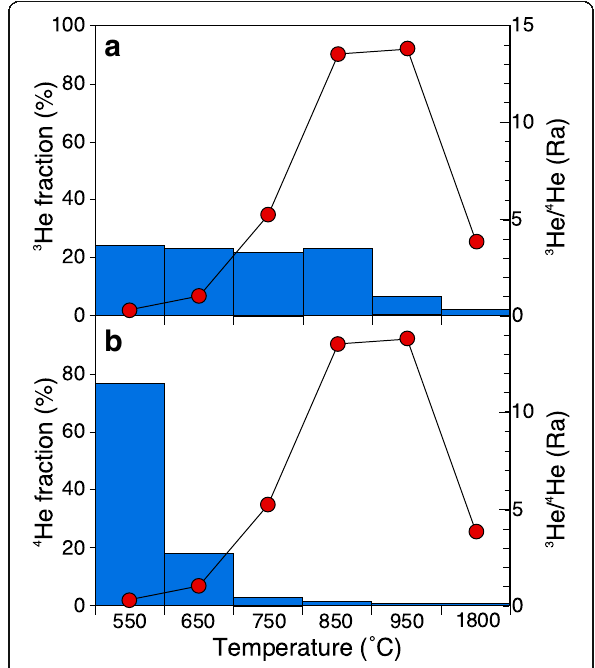
Fig. 3 Results of the stepwise heating experiments. 3 He ( a ) and 4 He ( b ) release profiles as a function of temperature for sample NF-37B. 3 He/ 4 He ratios for NF-37B are shown in each panel for comparison. Helium extracted at 850°C yielded a high 3 He/ 4 He ratio (14 Ra), suggesting release from IDPs. The stratigraphic level of sample NF-37B is shown in Fig.